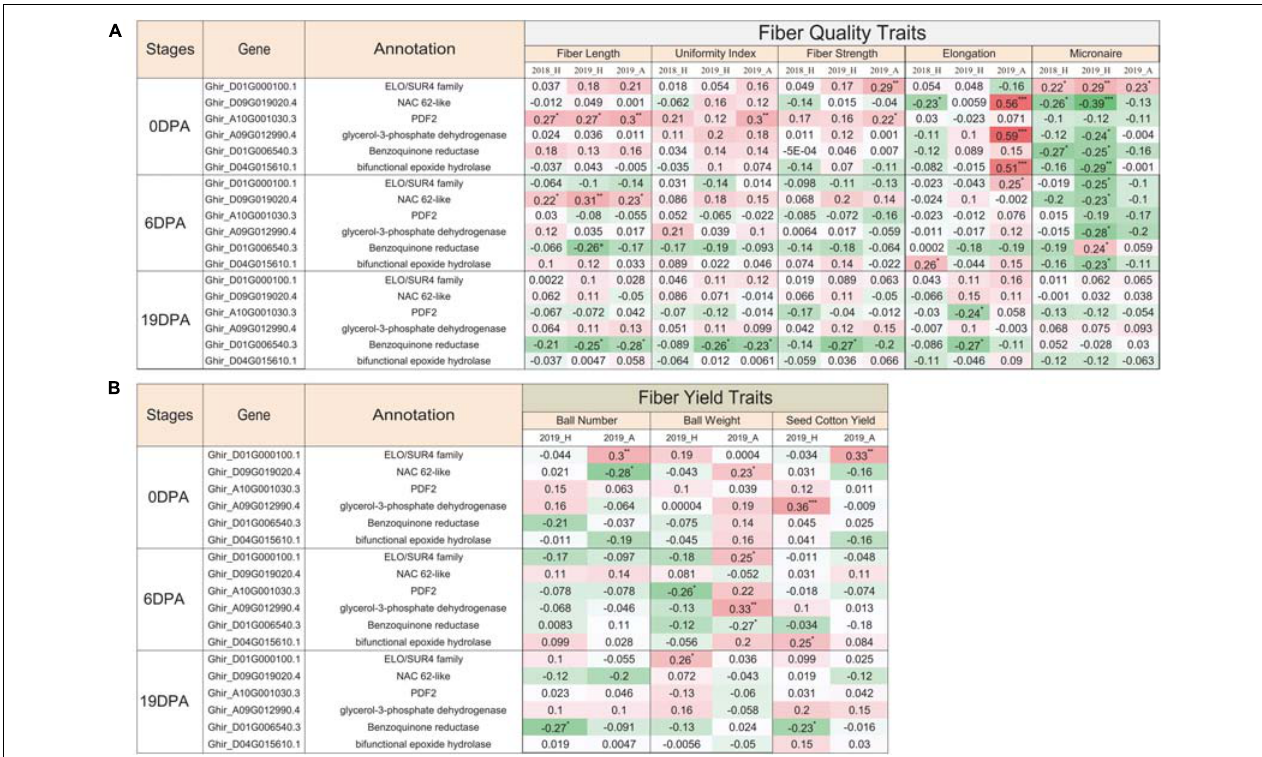
FIGURE 7 | Functional validation of EETs for different fiber-related traits. Pearson correlation coefficient of nanostring nCounter gene expression value of 100 cotton genotypes grown in 2018 at Hyderabad city with phenotypic characteristics of different (A) fiber quality-related traits and (B) fiber yield-related traits for three different conditions, viz., 2018_H, 2019_H, and 2019_A. 2018 and 2019 represented the two consecutive growing seasons, while H and A depicted as Hyderabad and Aurangabad cities of India, respectively. The green-colored cell represented the positive correlation, whereas the red-colored cell represented the negative correlation value. Significant correlation was denoted with the asterisk mask (*) in which *, **, *** used for the p -value ≤ 0.05, ≤ 0.01, and ≤ 0.005,